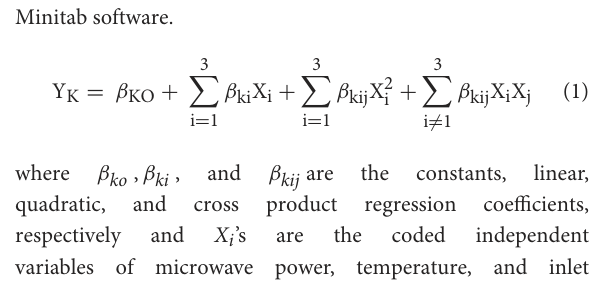
based on the available literature and preliminary